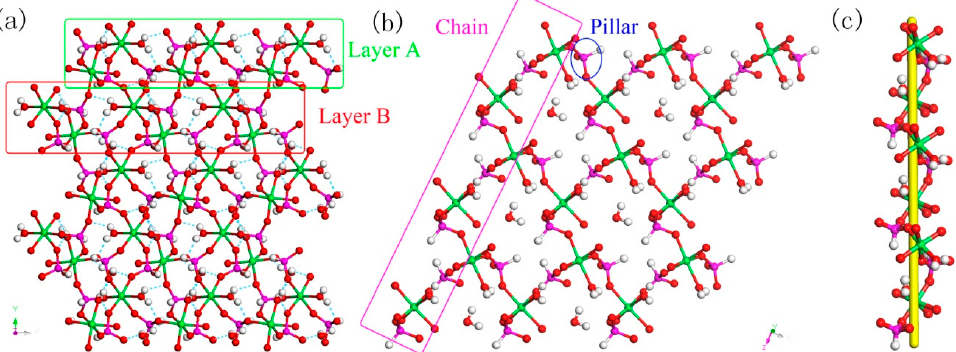
Figure 10. ( a ) The ABAB layer structure of 4 along (001) direction. ( b ) The 12-ring windows of 4 in (101) plane. ( c ) The left-handed helical chain of 4 . P, pink; In, green; H, white; O, red.